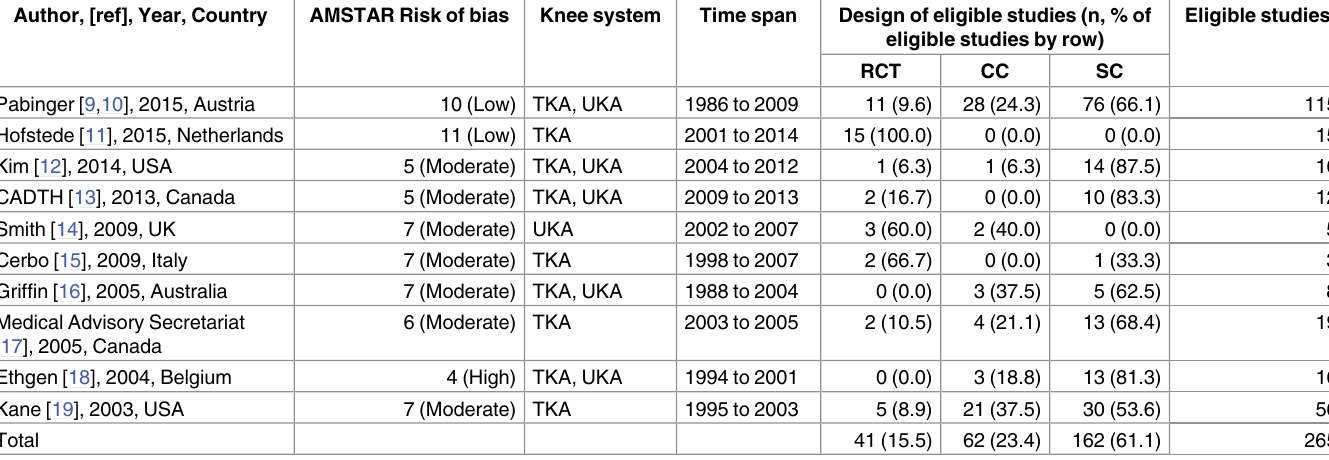
Table 1. Design of studies included in eligible health technology